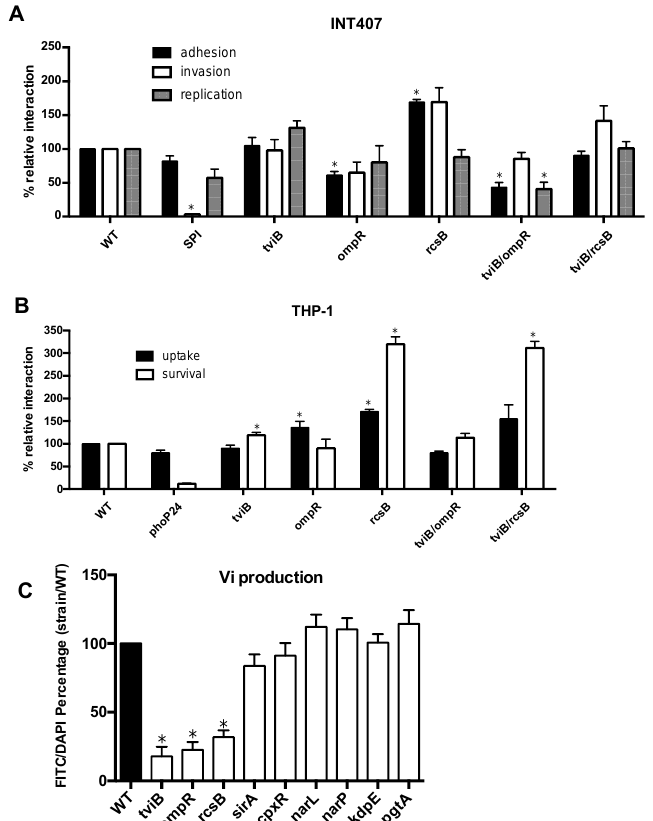
Figure 4. Role of Vi capsule. Epithelial INT-407 cells ( A ) and THP-1 macrophages ( B ) were infected with S . Typhi wild-type strain, the tviB , ompR, rcsB and the double mutant tviB-ompR and tviB-rcsB mutants. ( C ) Production of the Vi antigen by immuno-staining. All assays were conducted in triplicate and repeated independently at least three times. The results are expressed as the mean ± SEM of the replicate experiments. Significant differences (* p < 0.0001) in the level between the wild-type and the mutant were determined by the Student’s unpaired t -test.